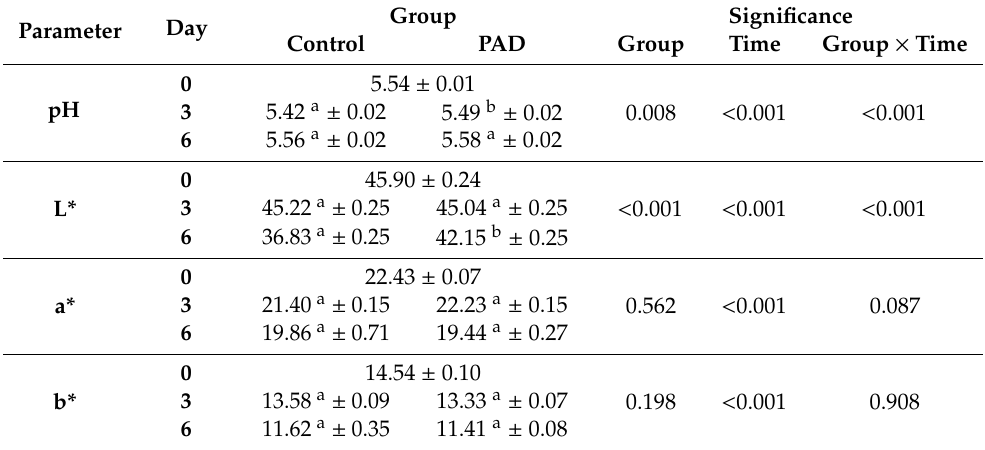
Table 1. E ff ect of packaging on the physical parameters of the meat during